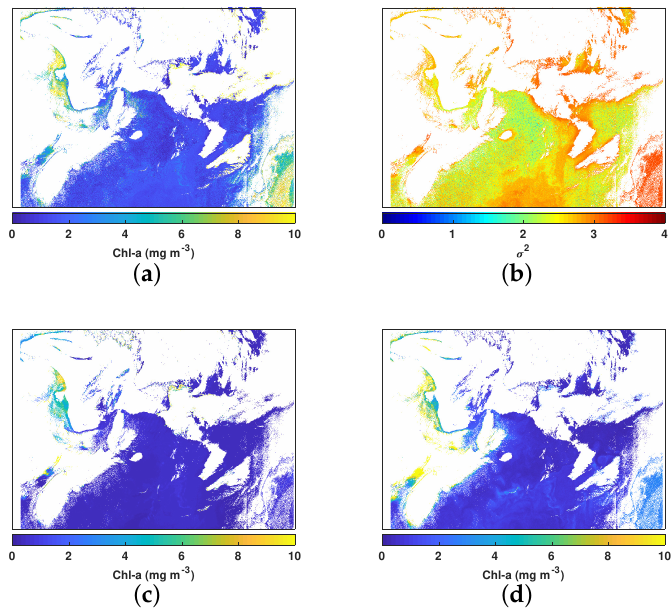
Figure A4. Estimated Chl-a in coastal and open waters for the enlarged area: ML GPR Balaton model ( a ) and corresponding certainty map ( b ), NN ( c ) and OC4 ( d ). The unit of Chl-a is mg m − 3 .